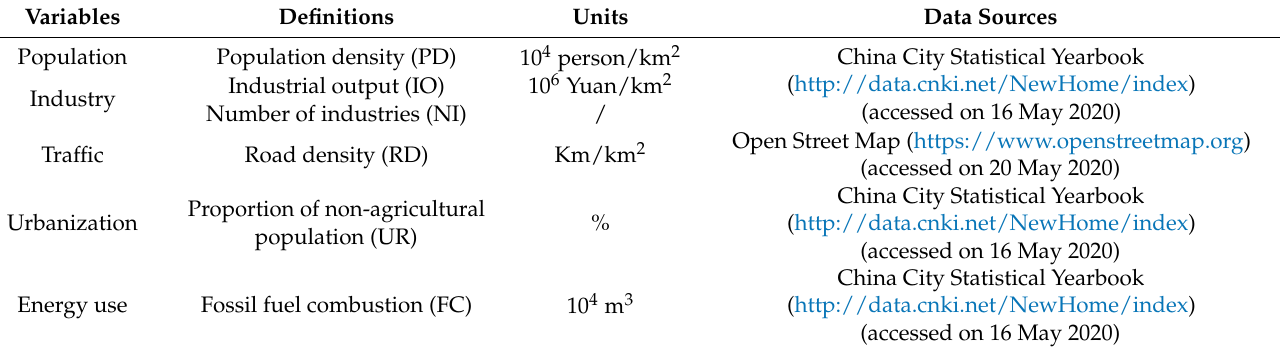
Table 1. Descriptions of the indicators for socioeconomic